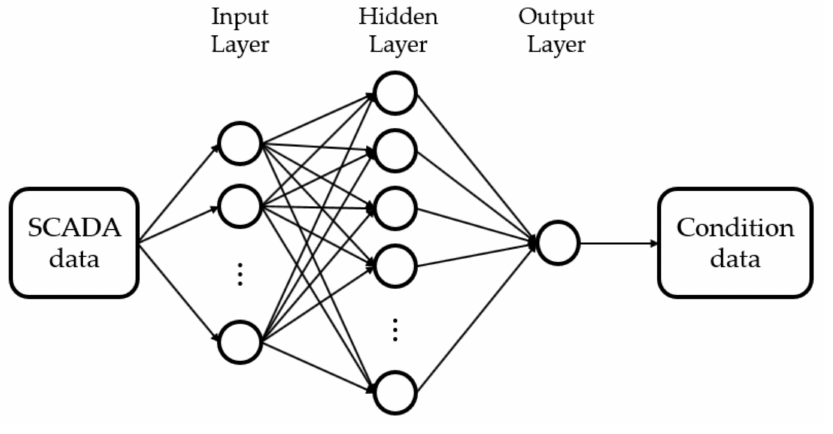
Figure 5. The structure of the neural network of the condition diagnostic